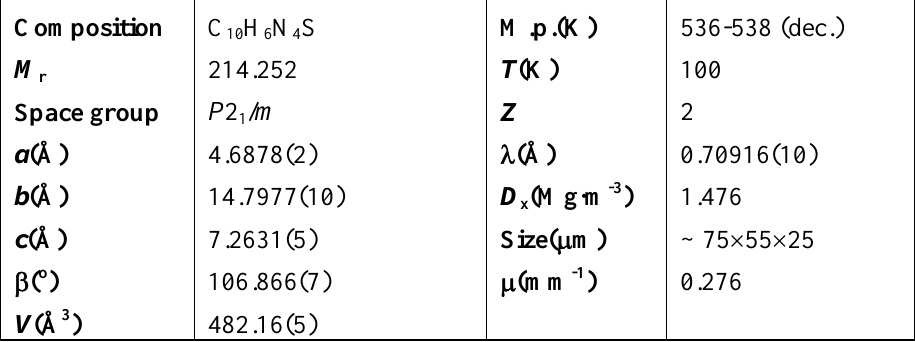
Table 2. Crystal data for compound